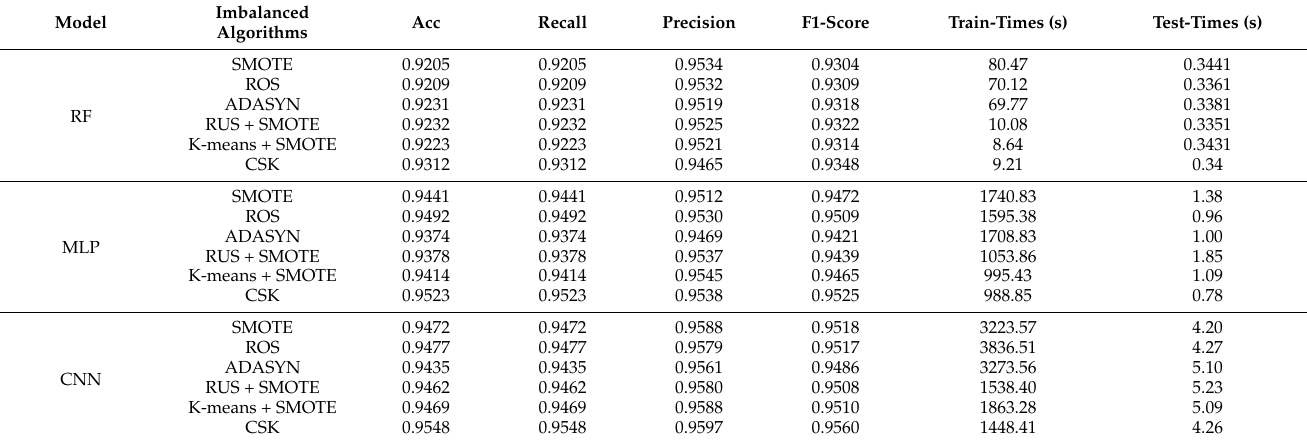
Table 7. Multi-classification Performance Results on UNSW-NB15 Dataset.